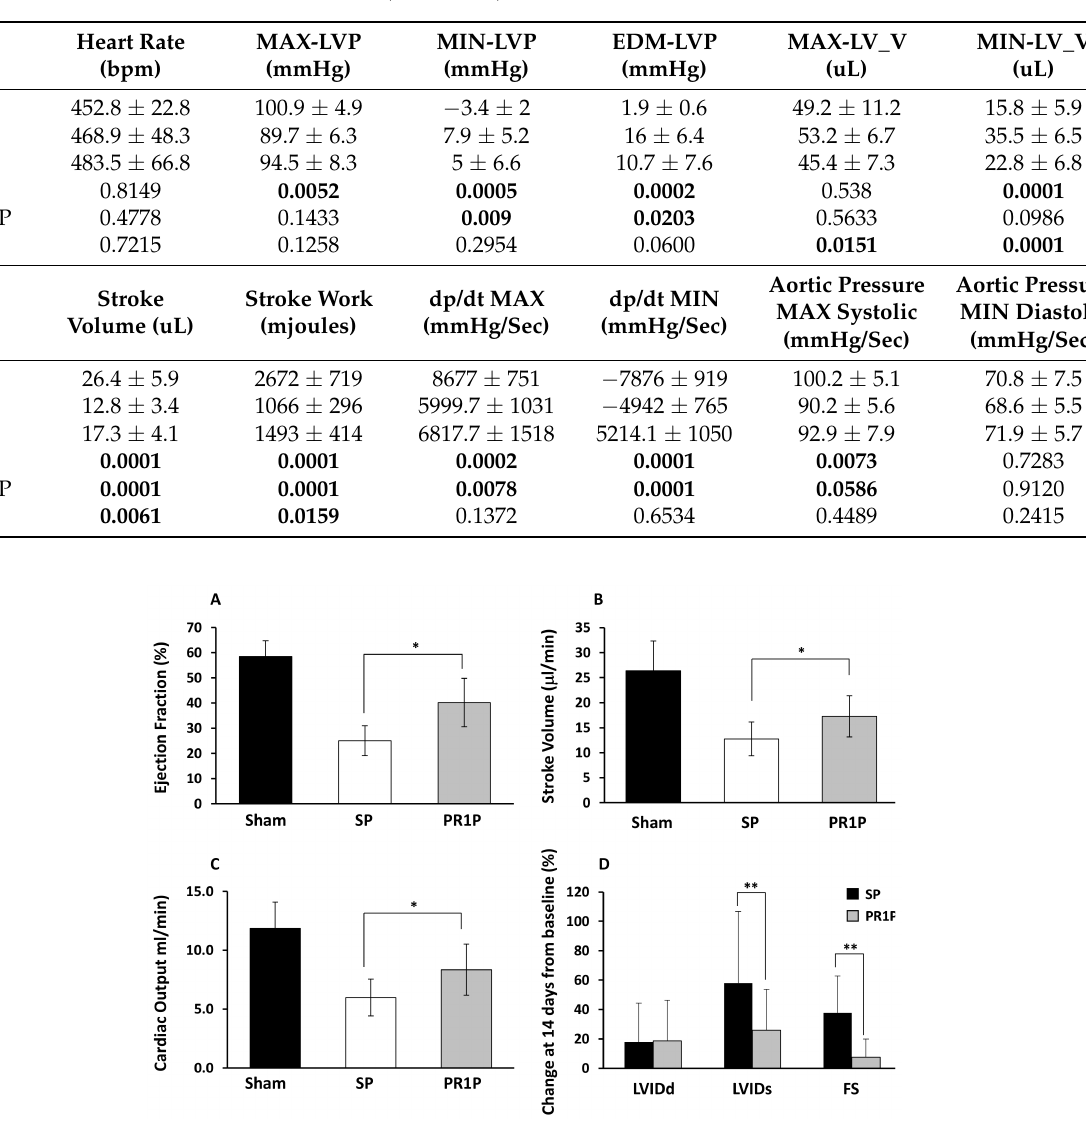
Figure 1. PR1P enhances the functional outcome of the heart following myocardial infarction in mice. ( A – C ) Bar graphs showing left ventricular ejection fraction (EF, A ) stroke volume (SV, B ) and cardiac output (CO, C ) measured using left ventricular vascular transducer catheters in anesthetized mice 14 days following sham surgery (Sham) and no treatment, or left coronary artery ligation and every other day intraperitoneal injections with scrambled peptide (SP) or PR1P. n = 6 SHAM, 17 SP, 18 PR1P. * p < 0.006 using ANOVA and Tukey post hoc analysis comparing PR1P vs. SP. ( D ) Bar graph